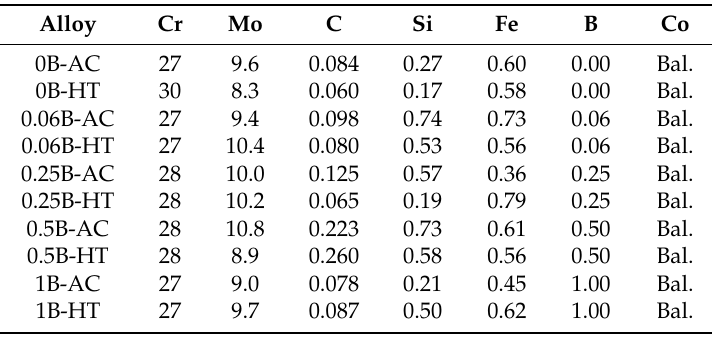
Table 1. Chemical composition ranges of the tested alloys, wt